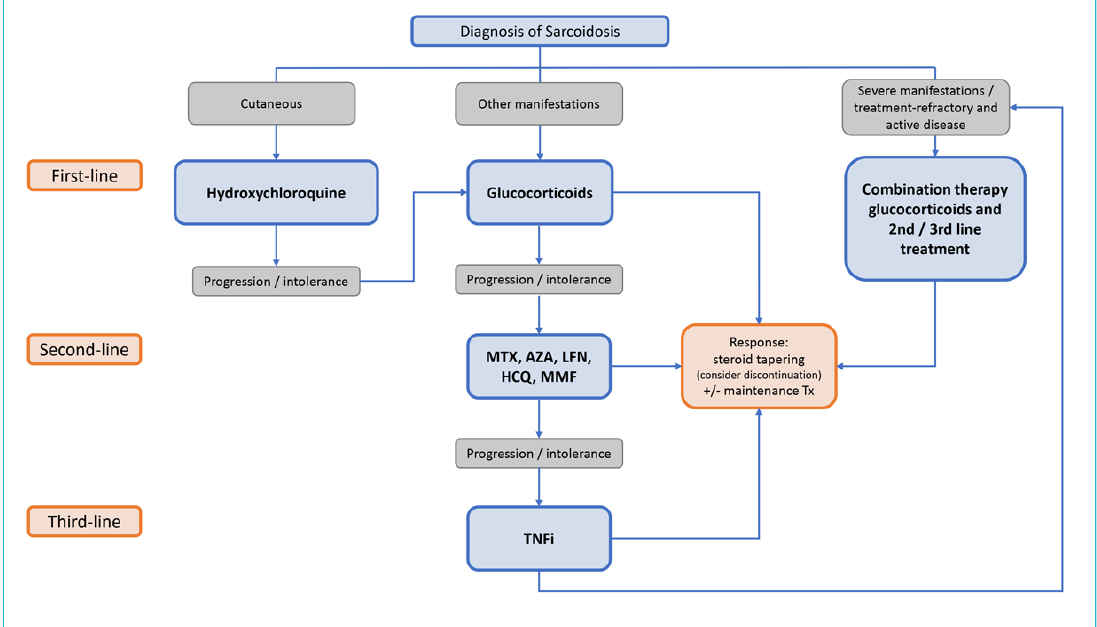
Figure 5: Algorithm of systemic treatments in sarcoidosis. MTX: methotrexate; AZA: azathioprine; LFN: leflunomide; HCQ: hydroxychloro- quine; MMF: mycophenolate mofetil; TNFi: TNFα